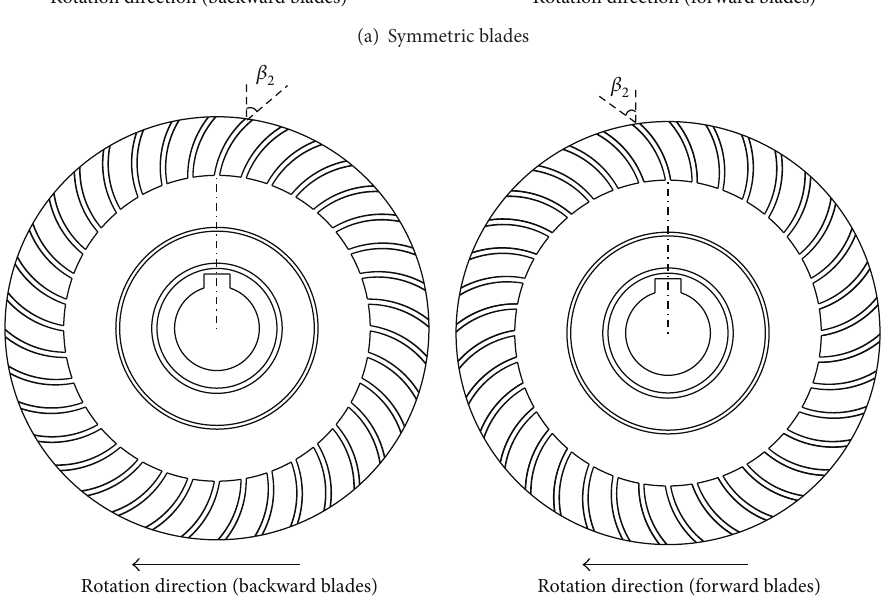
Figure 14: Schematic of blades: (a) symmetric blades and (b) nonsymmetric blades.